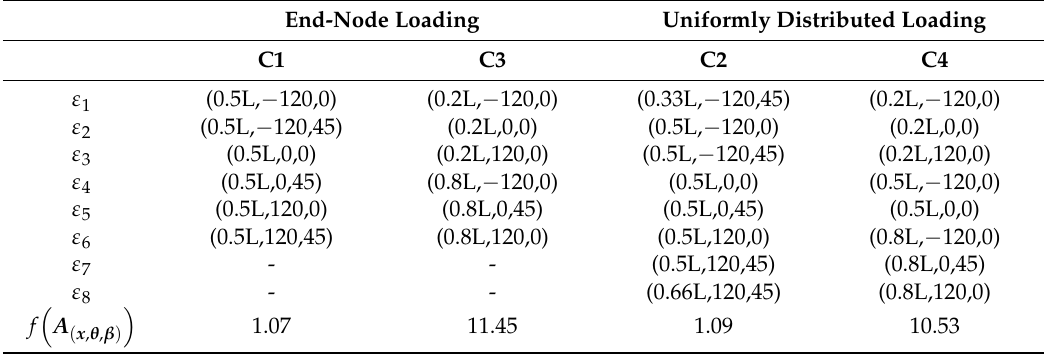
Table 1. Description of strain sensor configurations. For each configuration, axial locations and orientations of sensors reported as ( x i , θ i , β i ) and angles expressed in degrees.